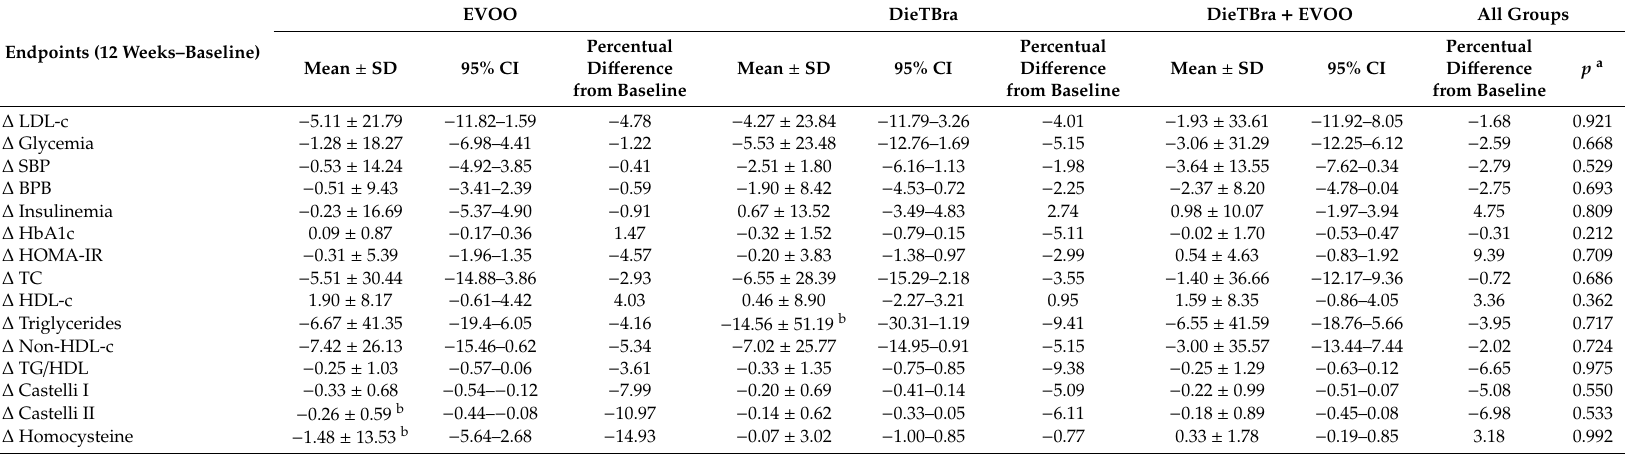
Table 3. Comparison of delta values and percentual di ff erence from baseline of cardiometabolic risk factors in severely obese individuals after 12 weeks of follow-up.